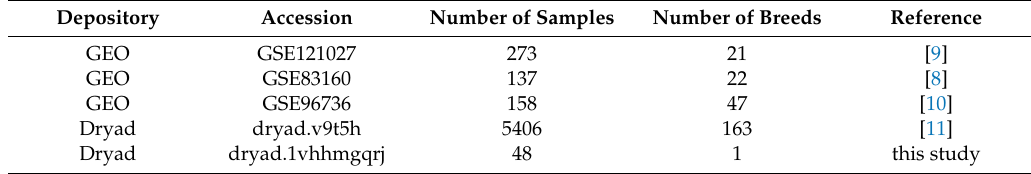
Table 1. Sources of Illumina CanineHD BeadChip datasets included in the